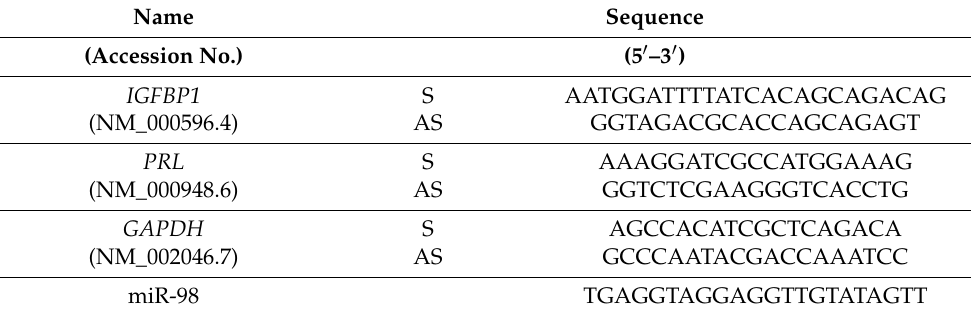
Table 1. Primers used for